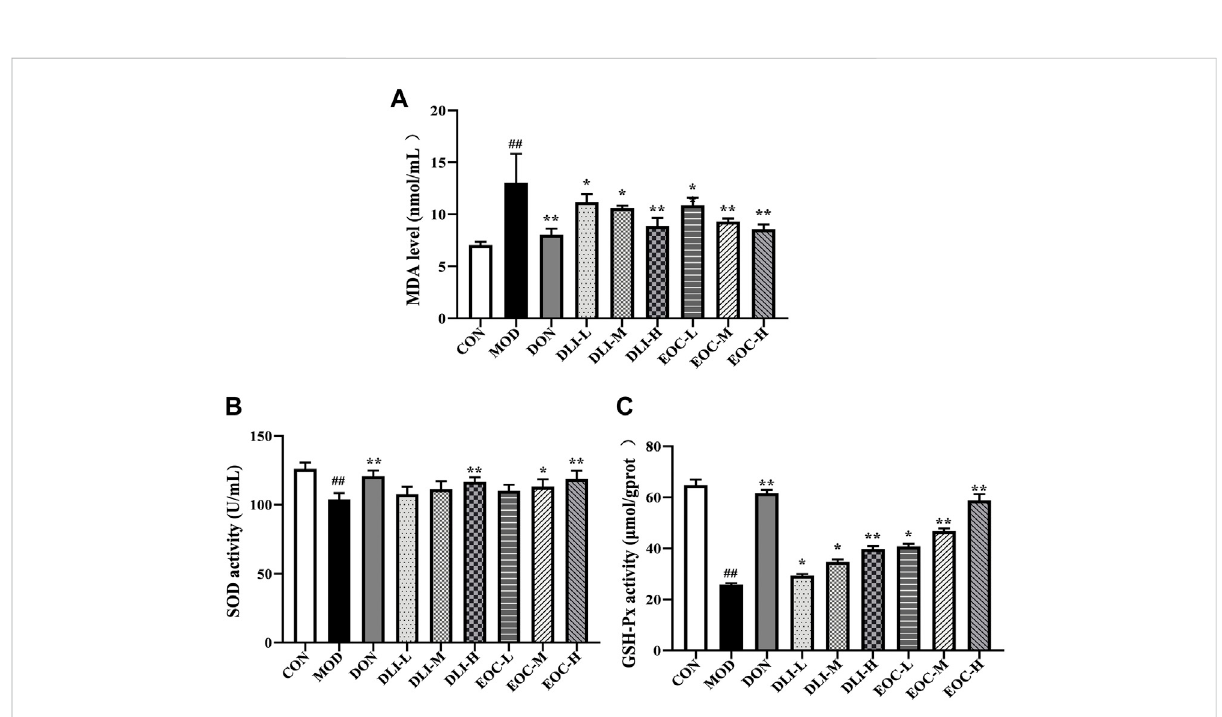
FIGURE 5 Effects ofEOC and DLI on brain SOD, MDA and GSH-Px in mice ( n = 5). (A) MDA. (B) SOD. (C) GSH-Px. # p < 0.05; ## p < 0.01 vs. theCON group; * p < 0.05, ** p < 0.01 vs. the MOD group.